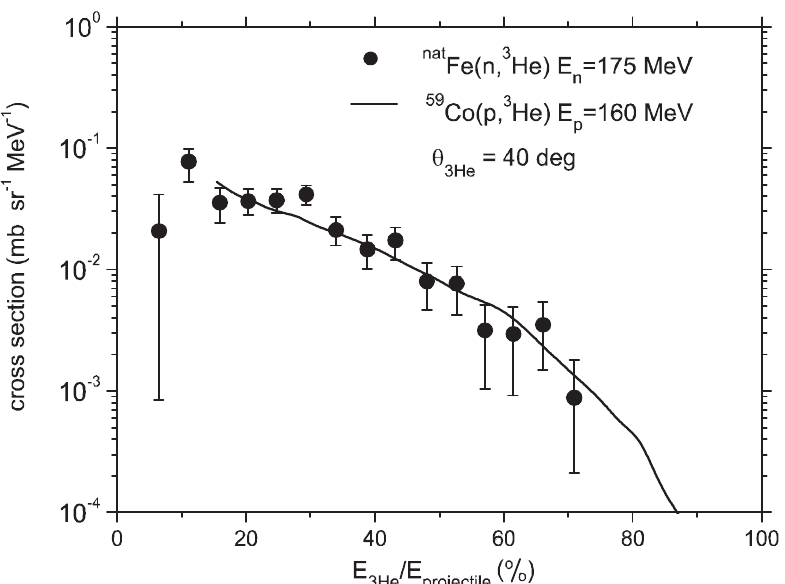
Fig. 1. Double differential cross section distribution for the reaction nat Fe(n, 3 Hex) from Bevilacqua [5] (data points with error bars) compared with the results of Cowley et al. [8] for 59 Co(p, 3 Hex) at an incident energy of 160 MeV. For clarity of representation, the data of Ref. [8] is shown as a curve drawn through those experimental points. The statistical uncertainty associated with the solid line is less than the symbol size used to display the data of Bevilacqua [5]. To correct for the difference in incident energy, results are displayed as a function of the ratio of emitted 3 He energy to the incident energy of the